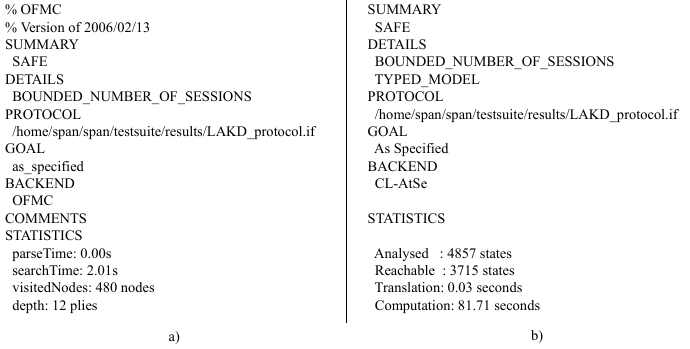
Figure 3. AVISPA verification results: ( a ) Using OFMC back-end. ( b ) Using CL-AtSe